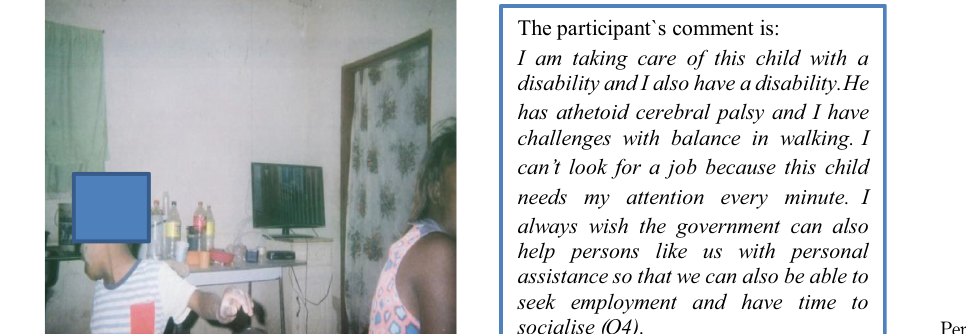
Figure 5. Personal assistance